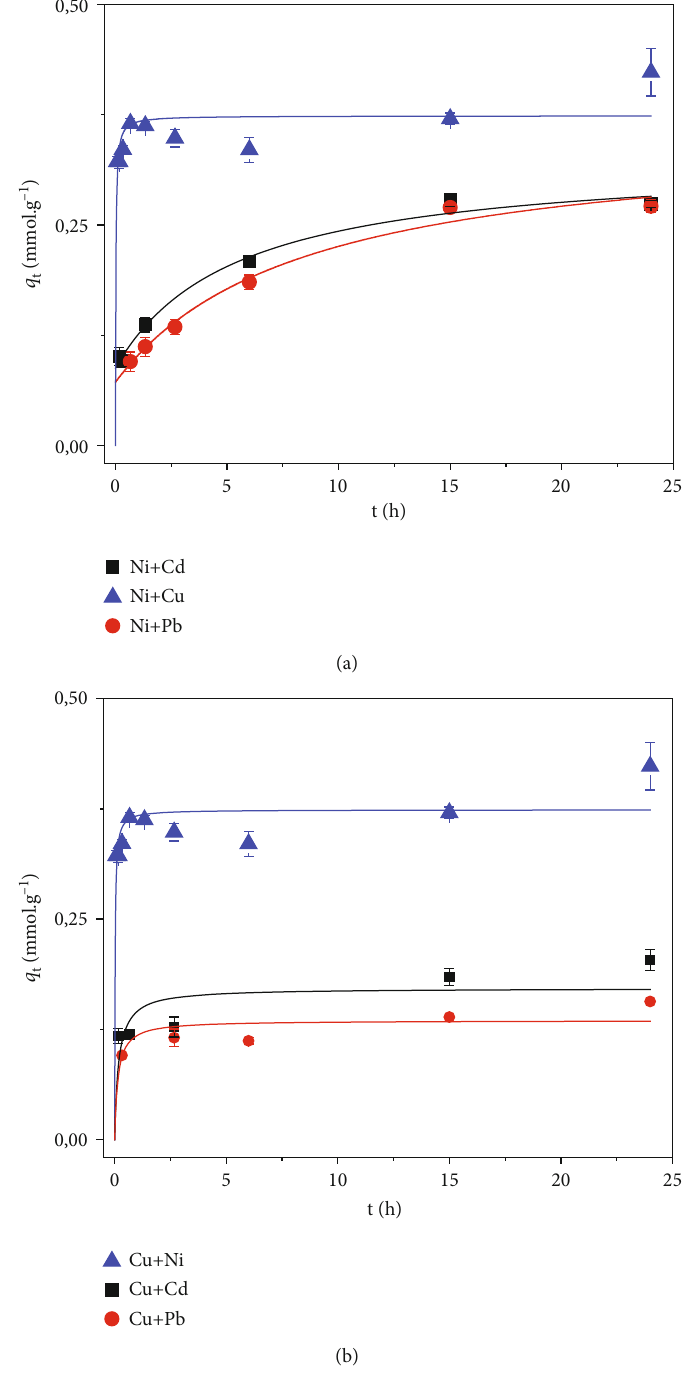
Figure 8: Adsorption kinetics for the total uptake in binary mixtures of (a) nickel and (b)